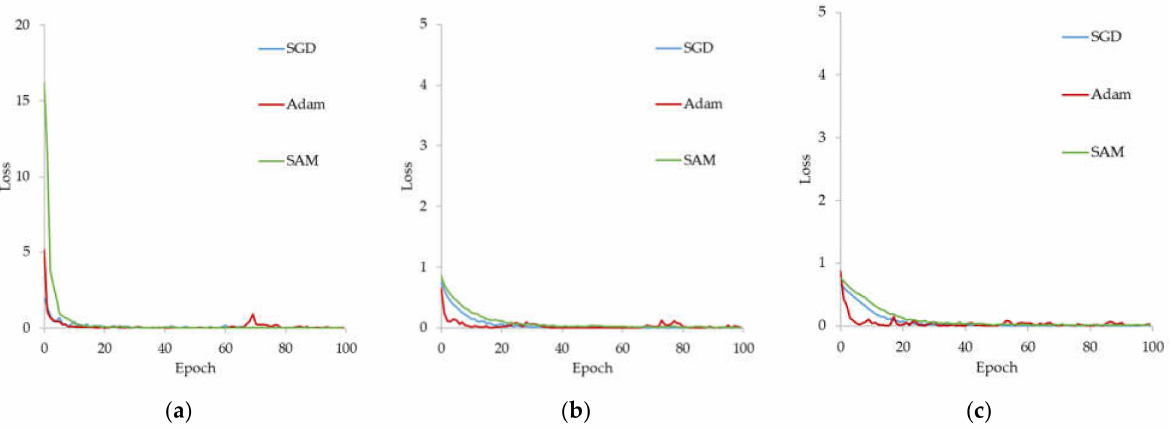
Figure 14. Training losses of CNN classifiers on the KRW dataset with various optimization methods: